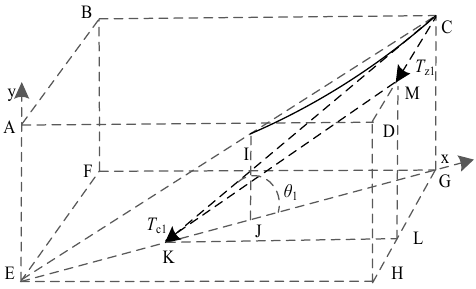
Figure 3. Analysis of the zigzag of the trolley wire on the left of the point C.